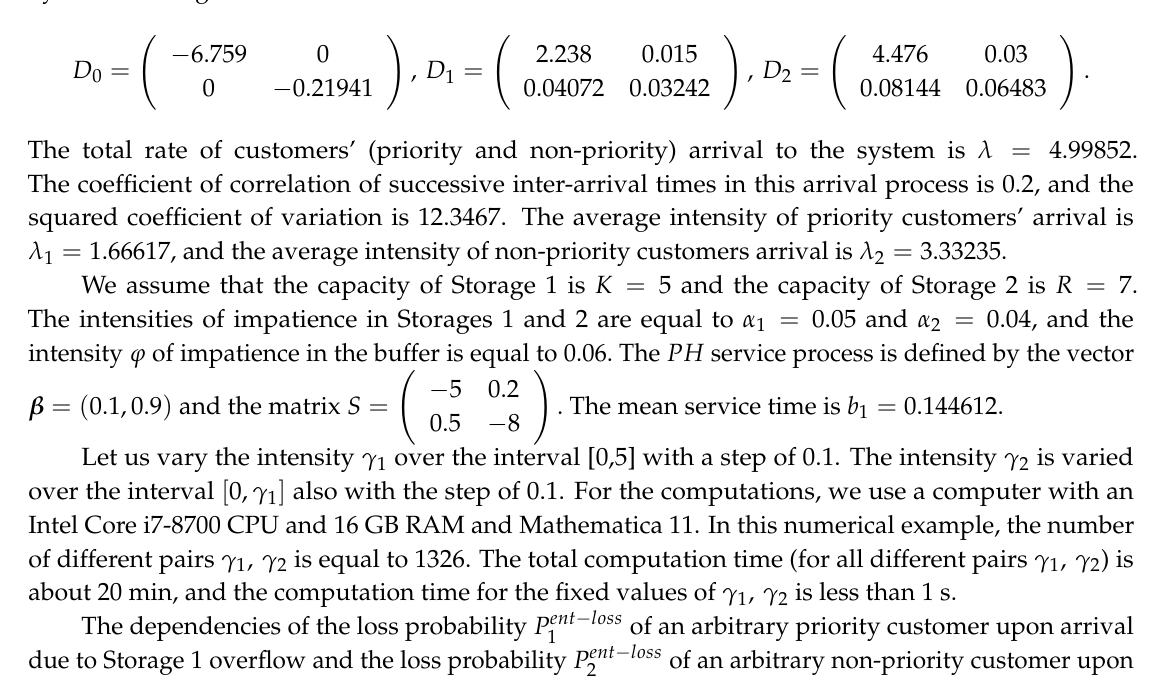
of arbitrary priority customer loss upon arrival due 1